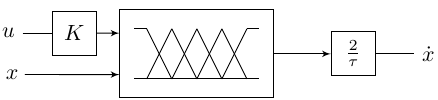
Figure 5. Scaling factors for the first-order